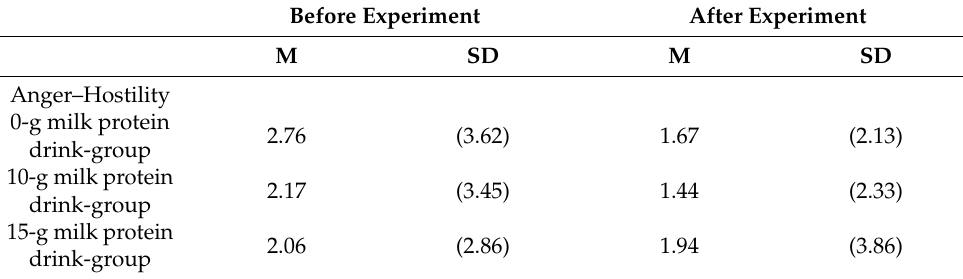
Table 7. Profile of mood state scores before and after the